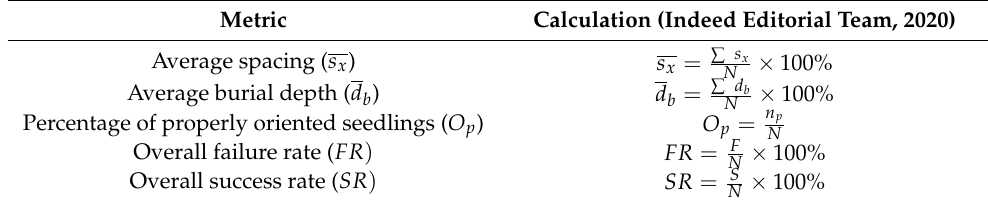
Table 6. Metrics and calculations used to evaluate transplanter